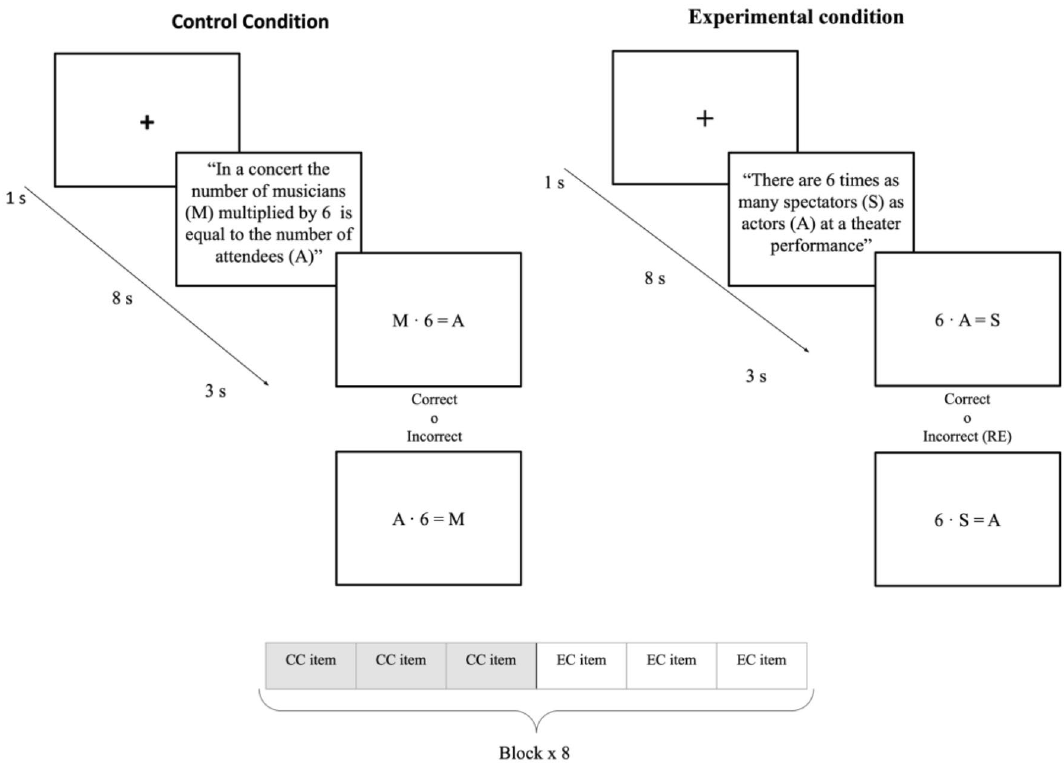
Figure 3. Schematic representation of the experimental design of the RE-task in fMRI. Note CC Control Condition, EC Experimental Condition. Each block presented with the same item corresponds to one of the eight experimental statement combinations (Multiplicative-Increased-Contextual, Multiplicative-Increased-Non Contextual, Additive-Decreased-Contextual,